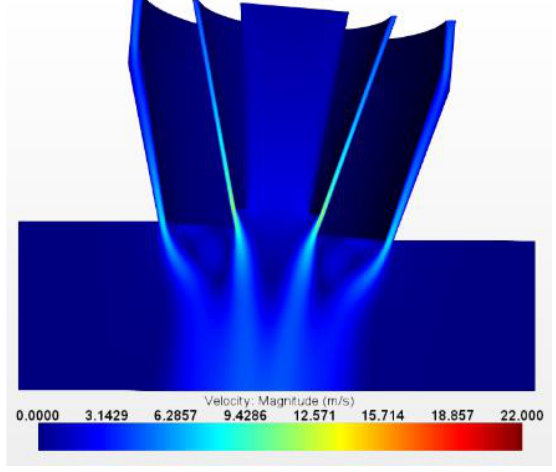
Figure 7: Simulation using condition B